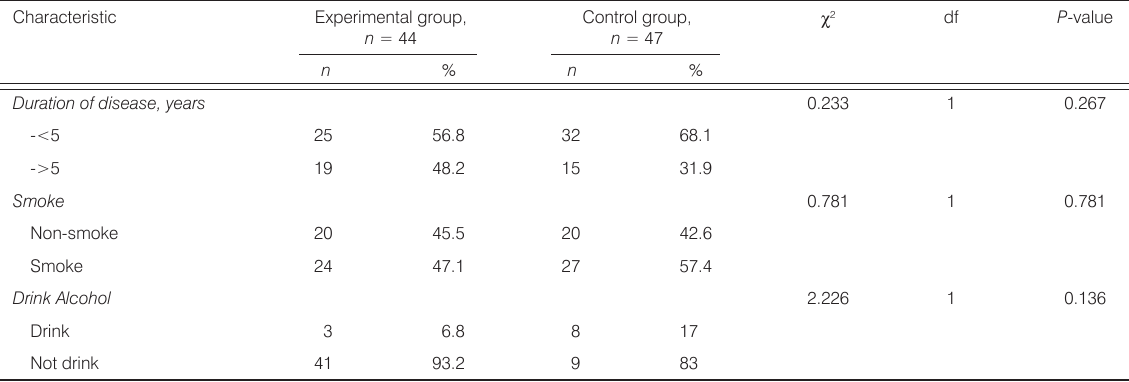
Table 2. Clinical